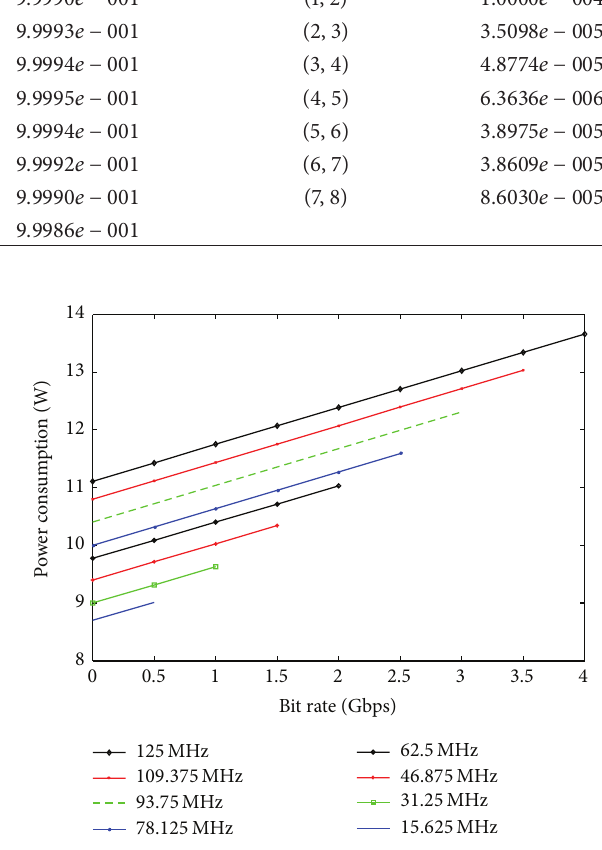
Figure 3: Power consumption model for a router with 8 clock frequencies.